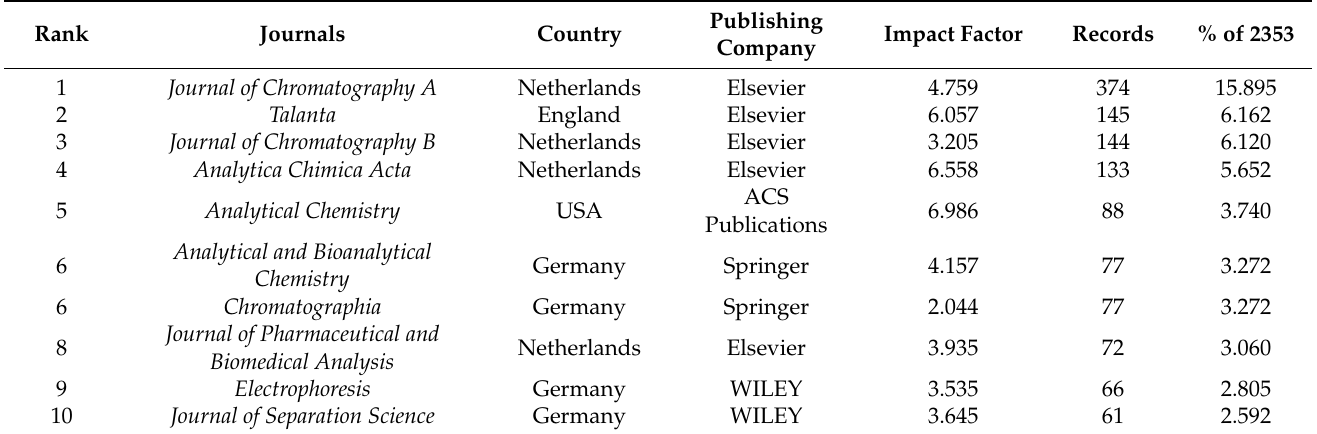
Table 1. Top 10 journals ranked by number of publications.